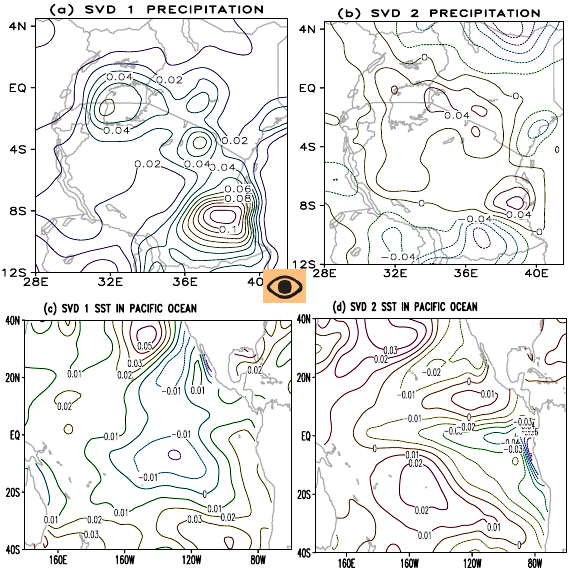
Figure 4. The homogeneous map of the first two modes of SVD for the Precipitation (mm/month) (a and b) and SST ( ° C) in Pacific Ocean (c and